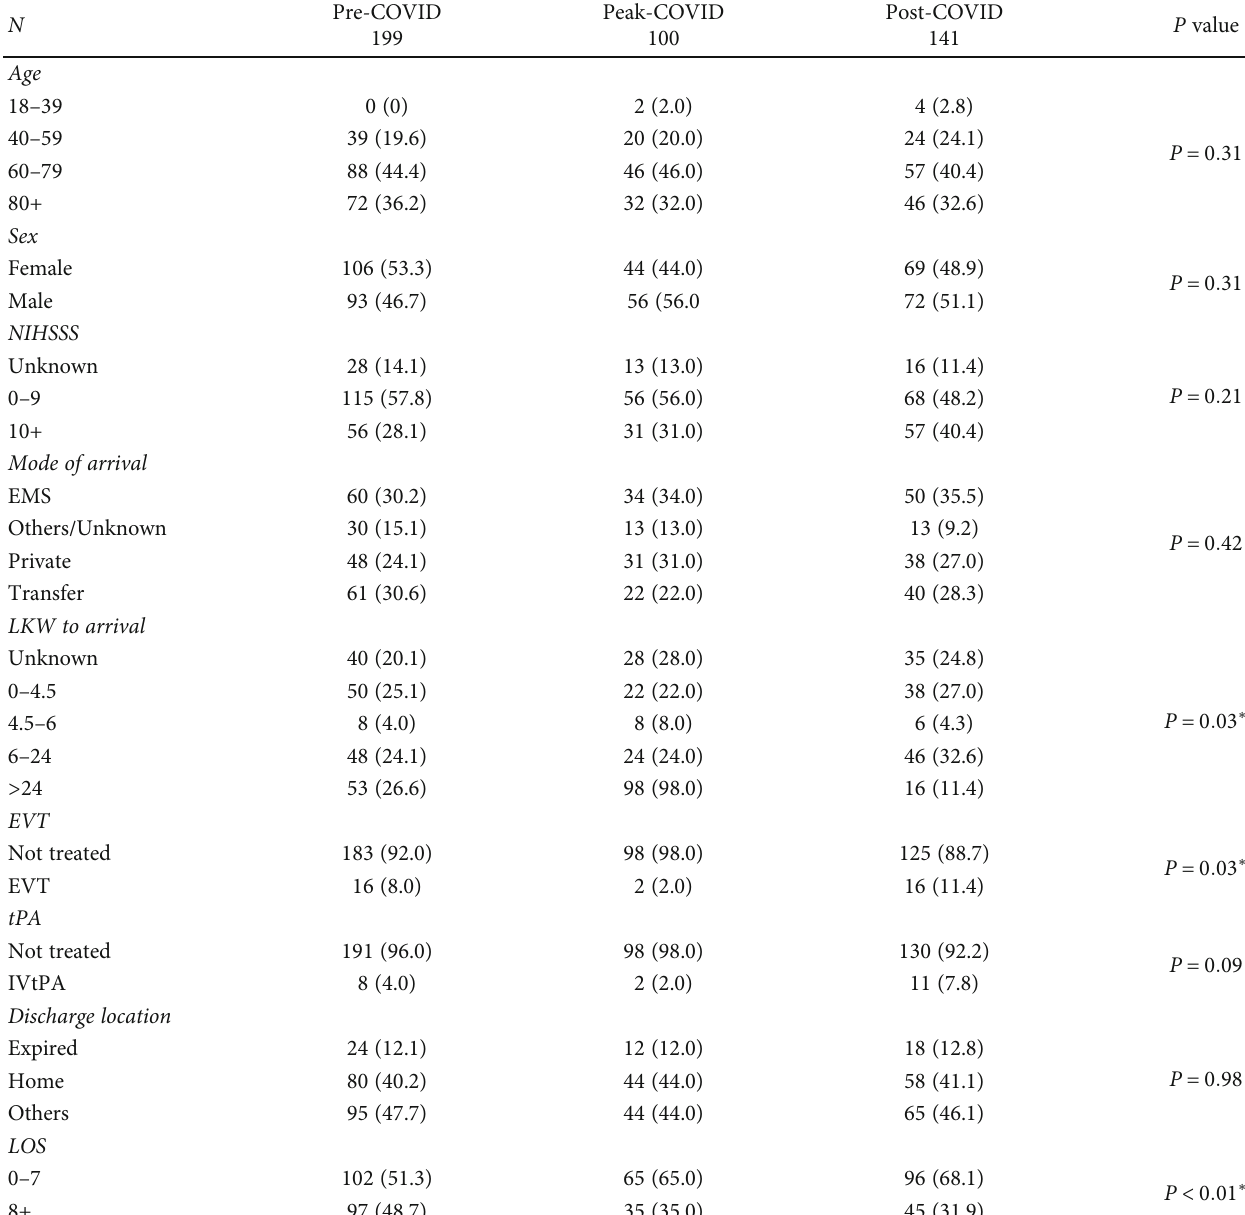
Table 3: Comparisons within 2020 time periods.